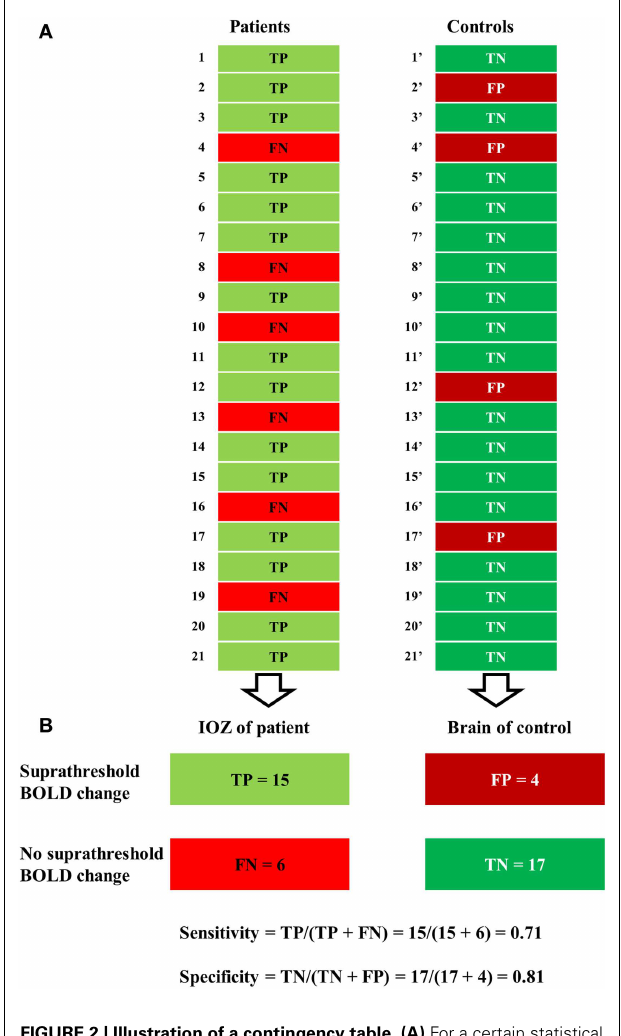
FIGURE 2 | Illustration of a contingency table . (A) For a certain statistical threshold, true-positive (TP) or false-negative (FN) cases are determined in patients, false-positive (FP) or true-negative (TN) cases in control subjects. (B) Sensitivity (number of true positives over the number of true positives and false negatives) was defined solely in the patient group and specificity (number of true negatives over the number of true negatives and false positives) solely in the control